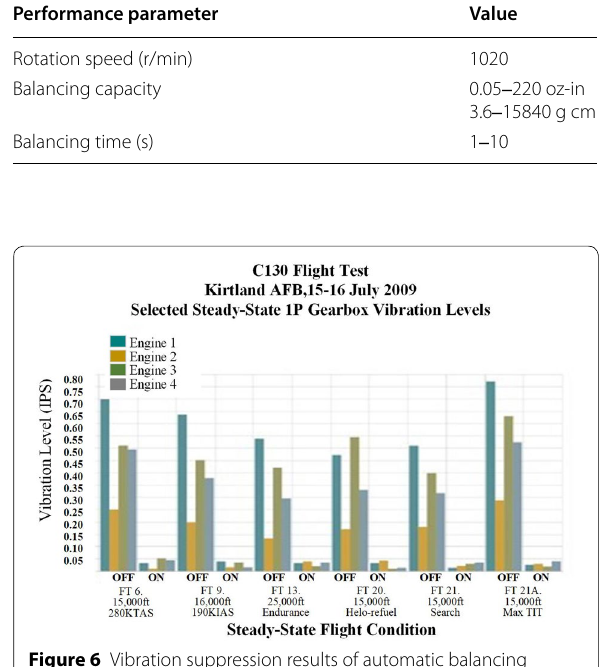
Figure 6 Vibration suppression results of automatic balancing system under several flight